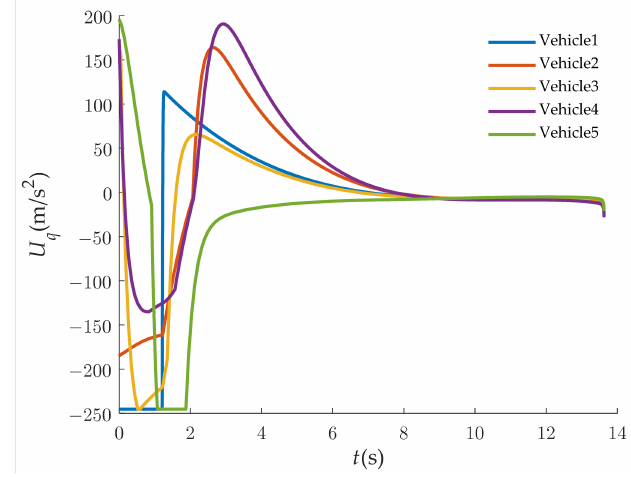
Figure 8. Control commands in normal direction of LOS.